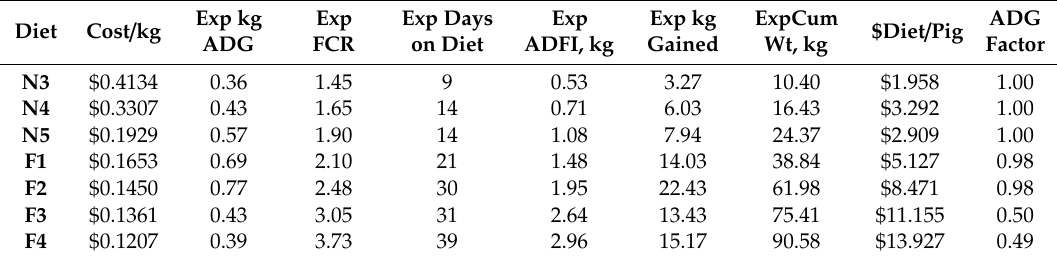
Table 5. Cluster I’s feed and gain calculations and initial assumptions. The model ADG factors (ADG Factor) that adjusted the progression of pig weight through each phase of cluster I in order that expected market weight match actual average market weight (110.04 kg). Expected days on Diet F4 (Exp Days on Diet = 74) changed to match the actual average days on feed (92 days, see Table 5).